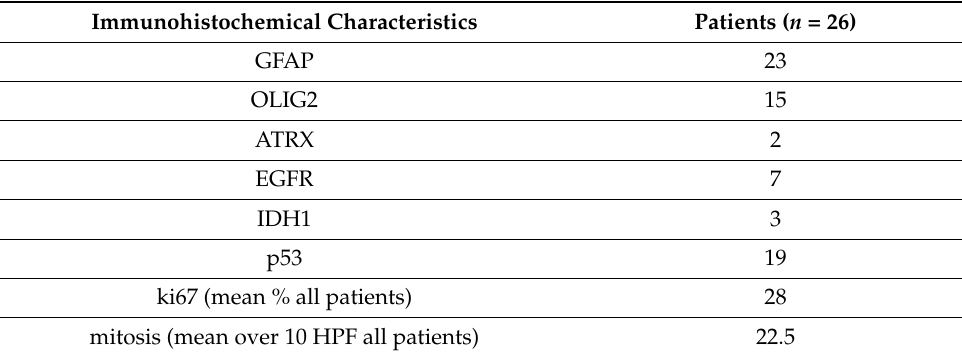
Table 2. Immunohistochemical features of the adult glioma cohort